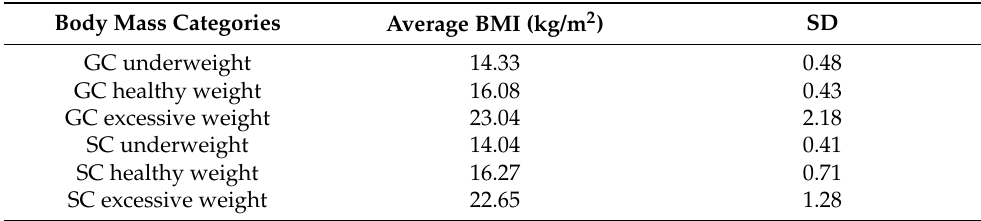
Table 5. The average BMI values of children in particular body mass categories during the entire study